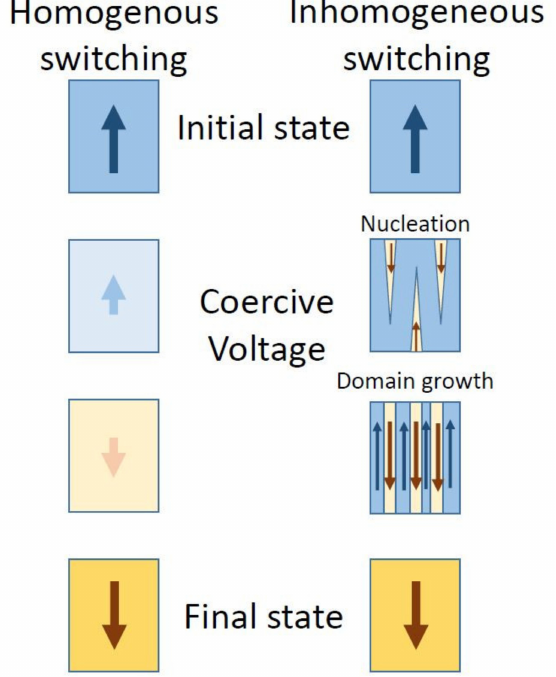
Figure 9. Left-homogeneous polarization switching, without domain formation (there is no nucle- ation phase of domains with opposite orientations of polarization; polarization merely flips from one direction to the other). Right-inhomogeneous switching, with domain formation (nuclei with opposite directions of polarization occur first, then they grow and coalesce until polarization is switched in the entire